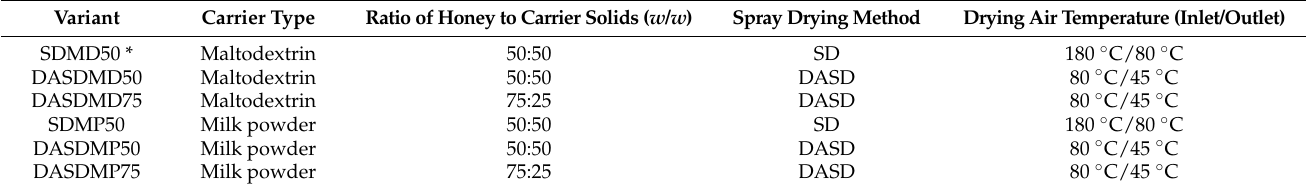
Table 2. Variants of spray dried buckwheat